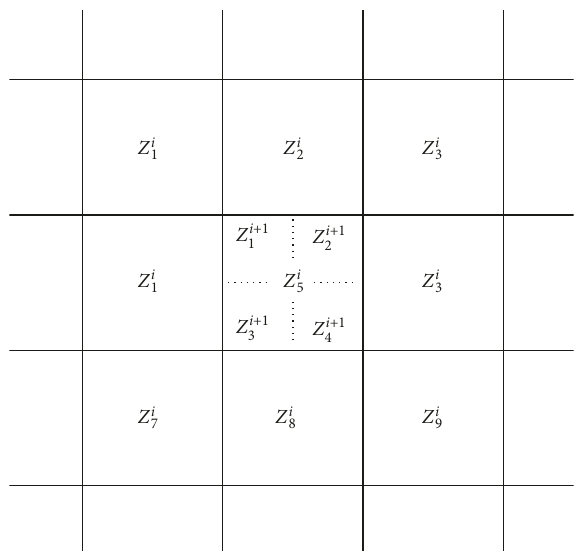
Figure 1: Schematic diagram of the subdivision process of LAS (after Ref.